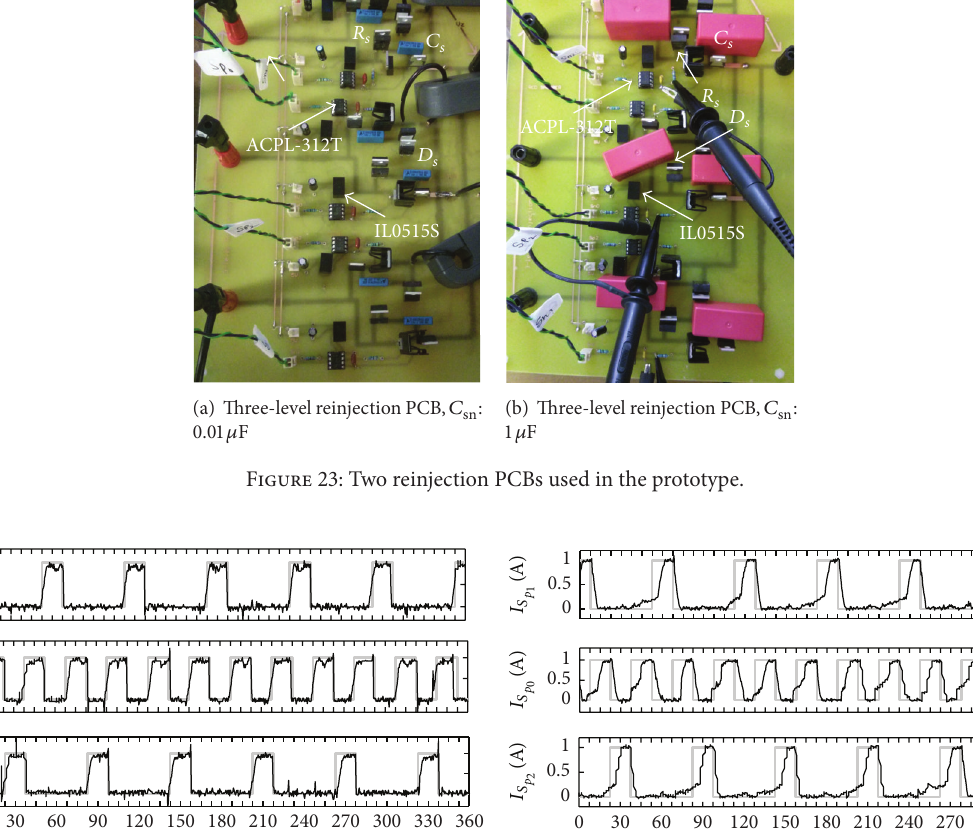
, 𝐼 𝑆 , and 𝐼 𝑆 through reinjection IGBTs. 𝑝1 𝑝0 𝑝2